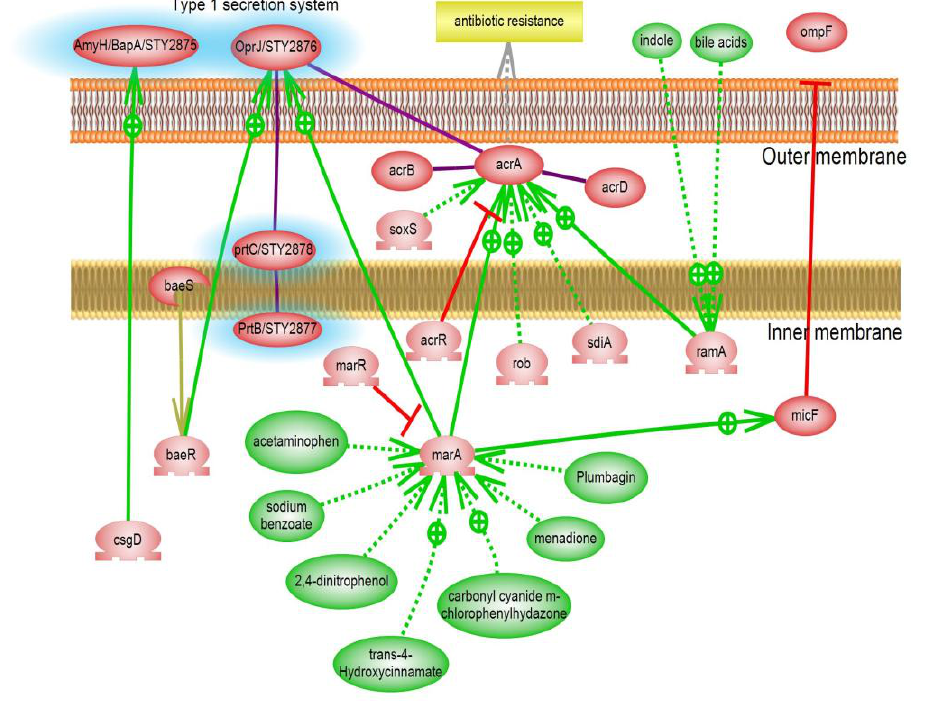
Figure 9: Multidrug resistance efflux pumps encoded by SPI-9. TolC, AcrAB, and BaeR regulate multidrug resistance to pump out bile acids, antibiotics, dyes, and disinfectants. Proteins encoded by SPI-9 are highlighted in blue. A detailed view of the SPI-9 pathway including supporting literature is available at http://www.ccbusm.com/publications/spi/SPI- 9.html.